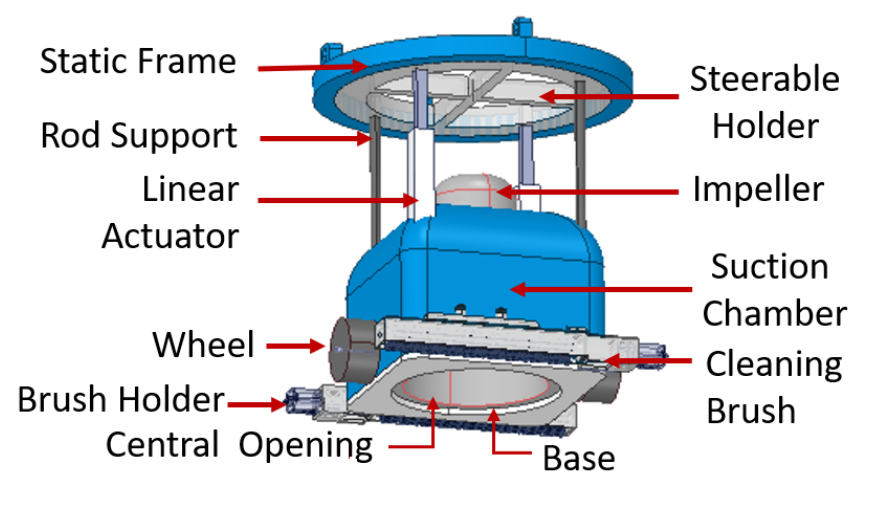
Figure 3. CAD model of the suction module of the entire